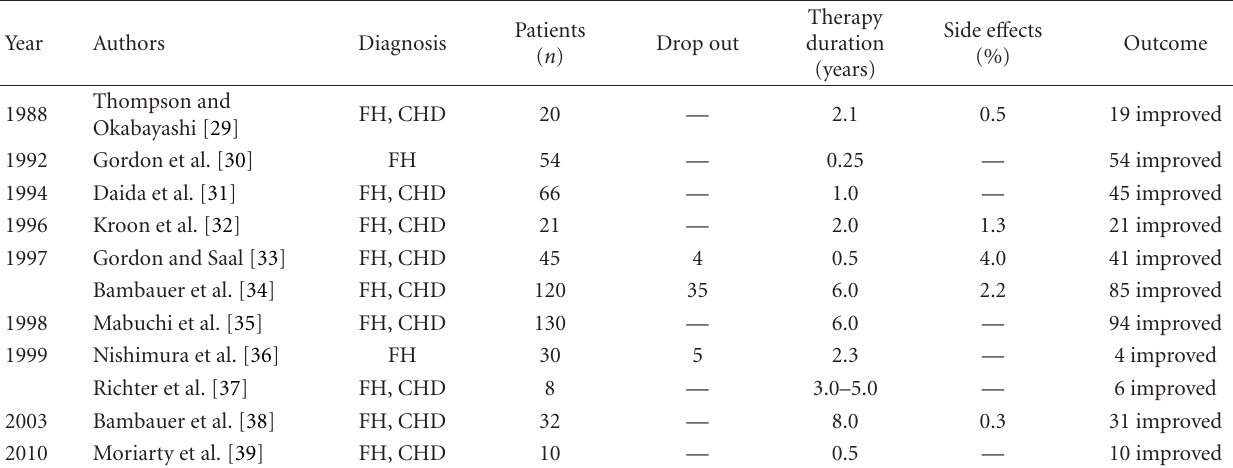
ESRD: end-stage renal disease and HTX: heart transplantation. Table 6: LDL adsorption with dextran sulfate (Liposorber LA-15, Kaneka, Japan) in hypercholesterolemia (selection of literature).